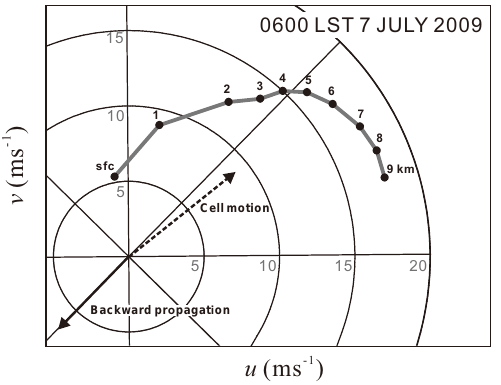
Figure 11. Hodograph computed using JMA-MSM gridded anal- yses averaged over the domain 33.7–36.4 ◦ N, 127.4–130.7 ◦ E (cf. Fig. 1) at 06:00LST 7 July 2009. The gray vectors denote the direction and speed of cell motion (dashed line) and backward prop- agation (solid line), respectively.